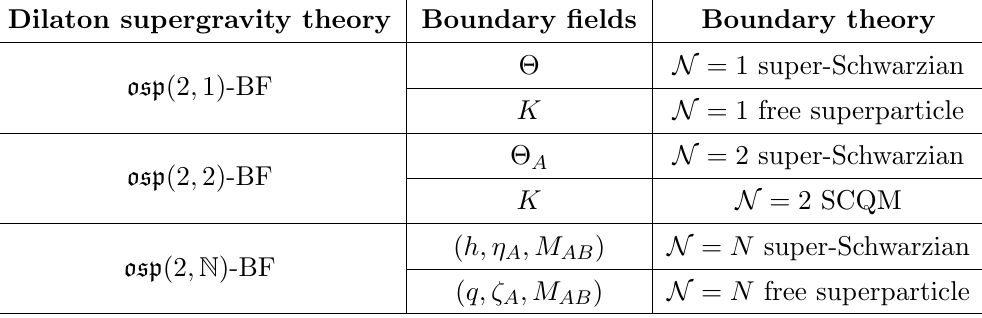
Table 1 . Boundary dynamics for (extended) dilaton supergravities in